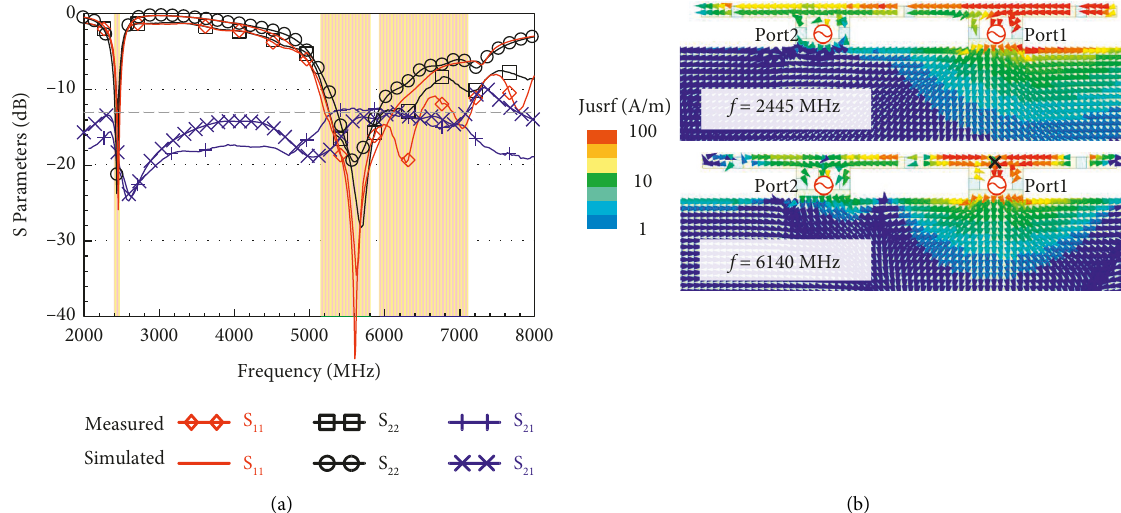
Figure 3: (a) Measured and simulated reflection and transmission coefficients; L 1, L 2, L 4, L 5 � 5.6nH, L 3 � L 6 � 18nH, L 7 � 8.2 nH. (b) The simulated surface current distribution of Ant1 excited at 2445 and